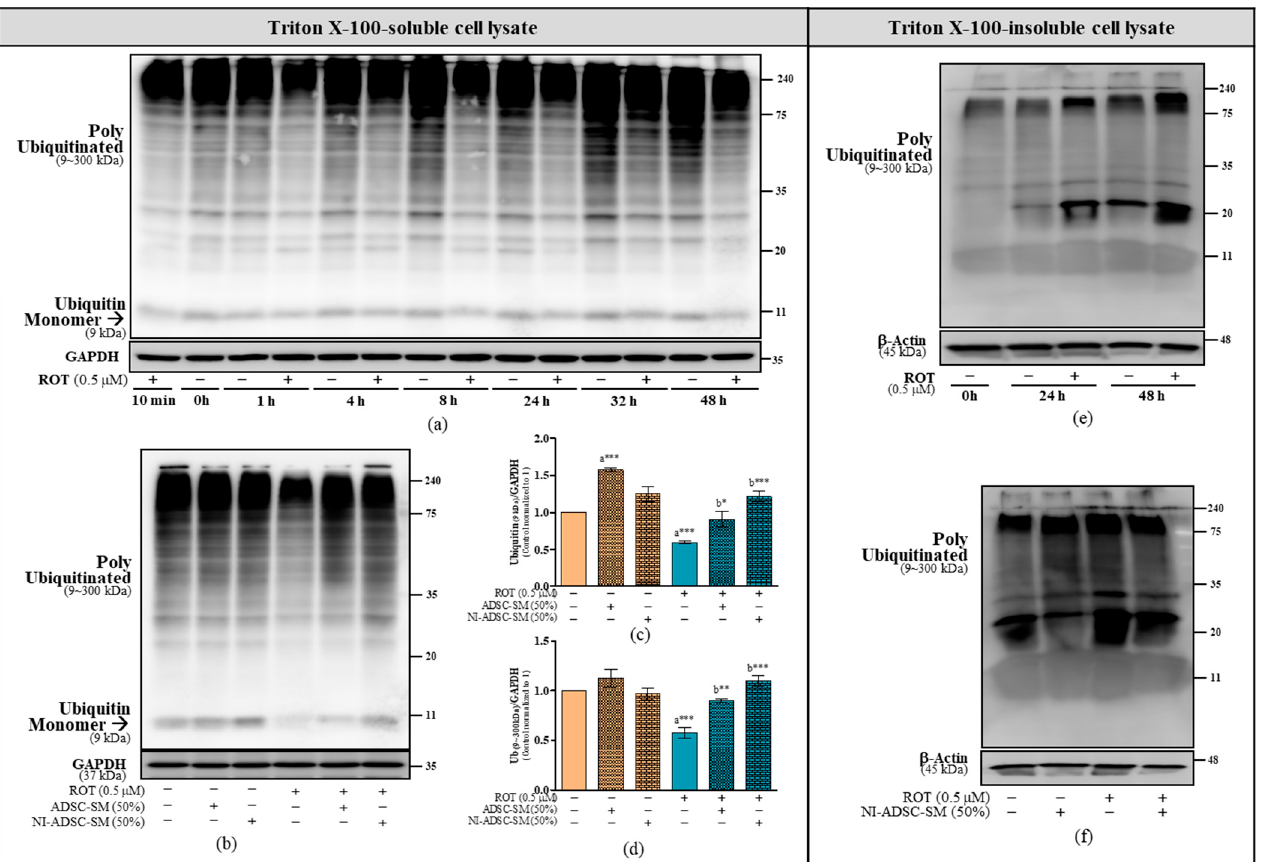
Figure 4. Effects of the NI-ADSC-SM on Ubiquitin (Ub). ( a , e ) Cells treated with or without ROT (0.5 µ M) at different timepoints were assessed for Ub protein expression in Triton X-100-soluble ( a ) and Triton X-100-insoluble ( e ) cell lysate fractions by Western blotting. ( b – d , f ) Cells were incubated in the presence of ROT (0.5 µ M) or DMSO for 48 h alone or with the ADSC-SM or NI-ADSC-SM (each diluted by 50%) during the last 24 h ( b ). The levels of Ub monomer at 9 kDa ( c ) and poly ubiquitinated at 9~300 kDa in the Triton X-100-soluble fractions ( d ) or in the Triton X-100-insoluble fractions ( f ) were assessed by Western blotting. Data are shown as the means (bars) and SEM (error bars) of three independent cell culture experiments. Statistical analysis was performed using one-way ANOVA with Tukey’s post-test. Statistical comparisons: a—compared with control; b—compared with ROT; * p < 0.05, ** p < 0.01, and *** p < 0.001.